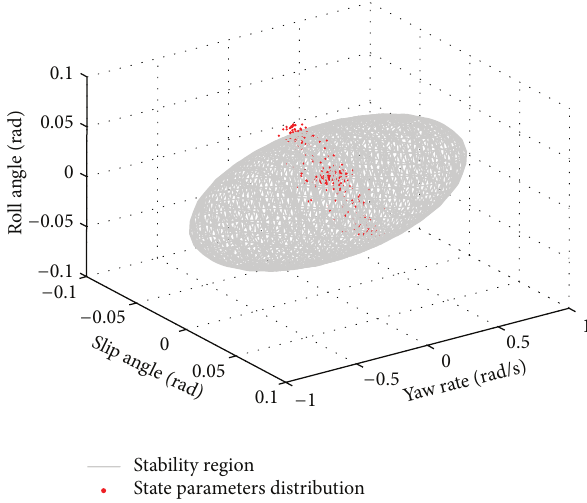
Figure 7: Stability region defined by 𝑉(𝑥) = 0.15 in 20m/s.